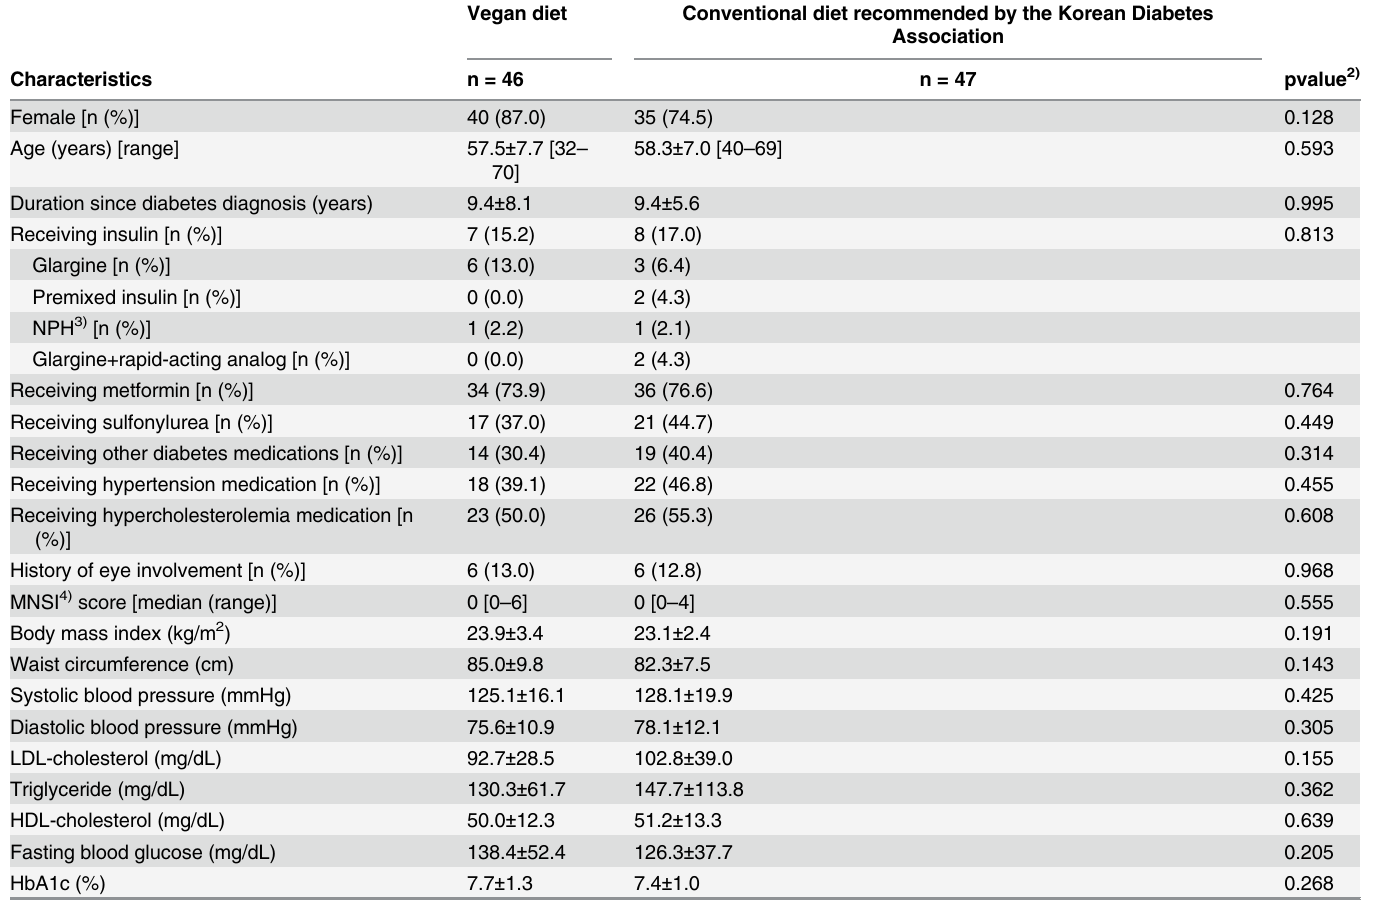
Table 1. General and clinical characteristics 1) of study participants at baseline (week 0).